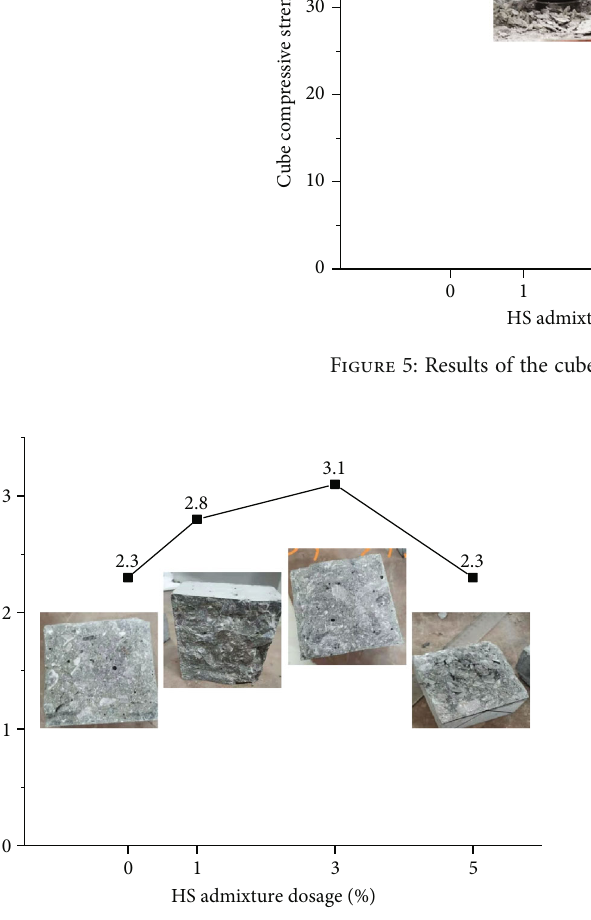
Figure 6: Results of the splitting tensile